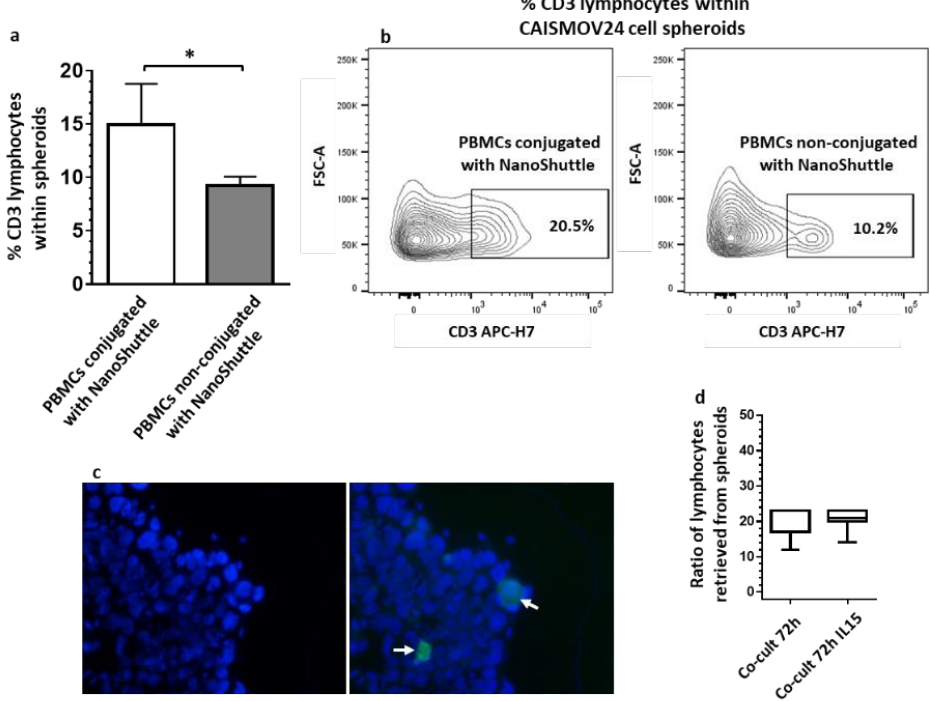
Figure 2. Analysis of the contents of lymphocytes in CAISMOV24 cell aggregates obtained by 3D co-culture of CAISMOV24 cells with PBMCs. ( a ) 3D co-cultures performed with NanoShuttle-conjugated PBMCs ( n = 6 experimental repetitions) have significant (* p < 0,05) higher percentages of CD3 lymphocyte subset than co-cultures performed with PBMCs non-conjugated with NanoShuttle ( n = 3 experimental repetitions). ( b ) Contour plots from a representative assay performed with NanoShuttle-conjugated and non-conjugated PBMCs from the same blood sample. ( c ) Fluorescence microscopy from a representative cryo-section of cell aggregates showing CFSE-labelled PBMCs (arrow). ( d ) The ratio of lymphocytes retrieved from cell aggregates is similar between co-cultures at 72 h that were supplemented or not with IL-15 ( n = 7 experimental repetitions).